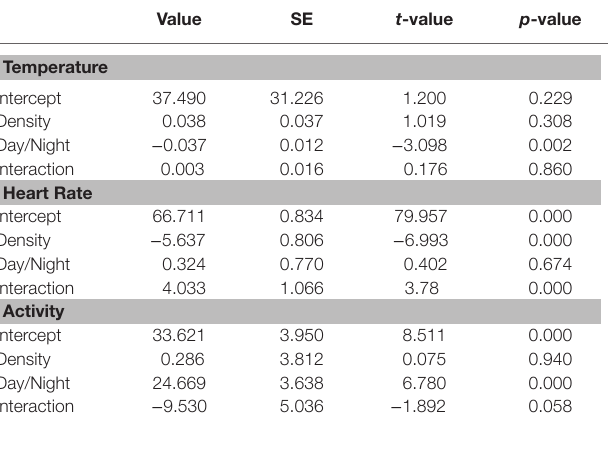
TABLE 1 | Matrix of coefficients of the mixed model applied to test the significance of the differences in temperature (T), heart rate (HR), and activity (ACT) of six cows that were maintained at 1.5 livestock units per hectare (LSUs/ ha; low density, LD) and were moved to a grazing area that had a density of 128 LSUs/ha (high density,